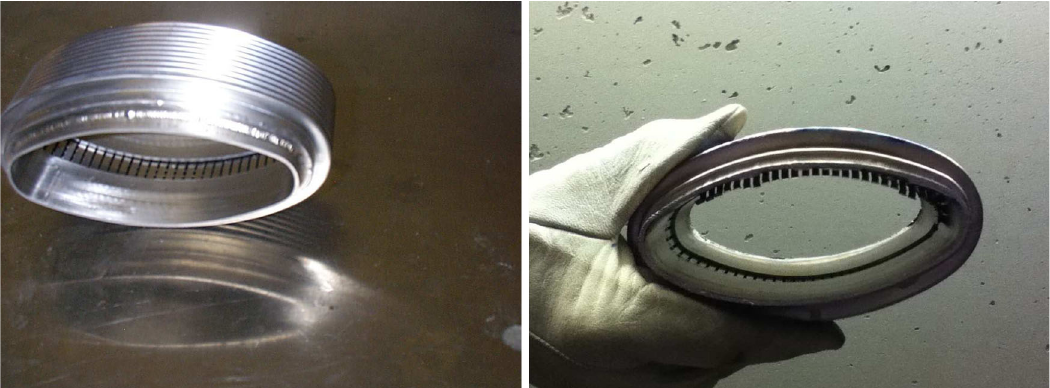
FIG. 12. Elliptical formed bellows used throughout Main Injector to connect beam pipes. Fingers shield beam to provide smooth transition for rf image currents. Failed bellows removed on March 7, 2011. Misinstalled bellows allowed fingers to escape so vertical aperture was reduced by (cid:4) 5 mm .